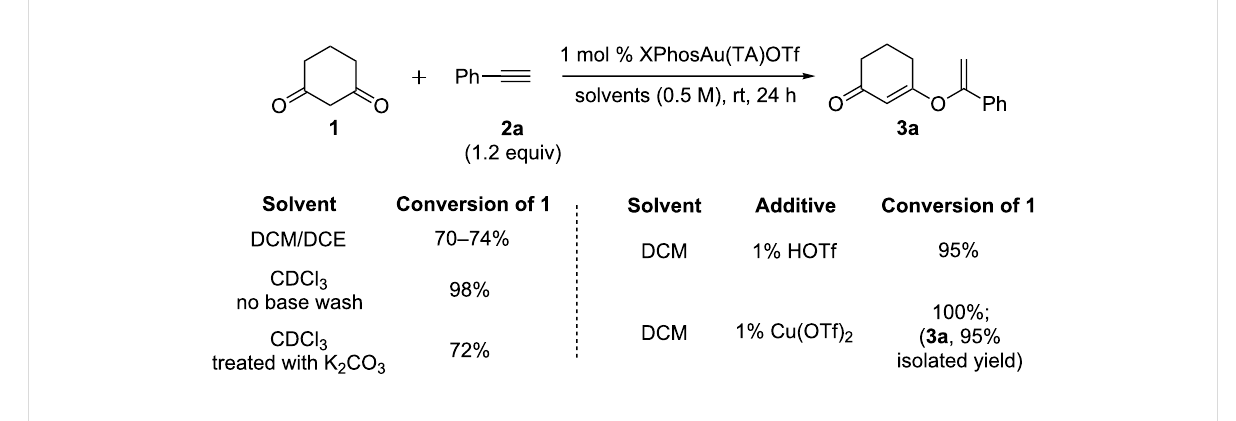
Scheme 2: Acid as the critical additive for optimal performance.